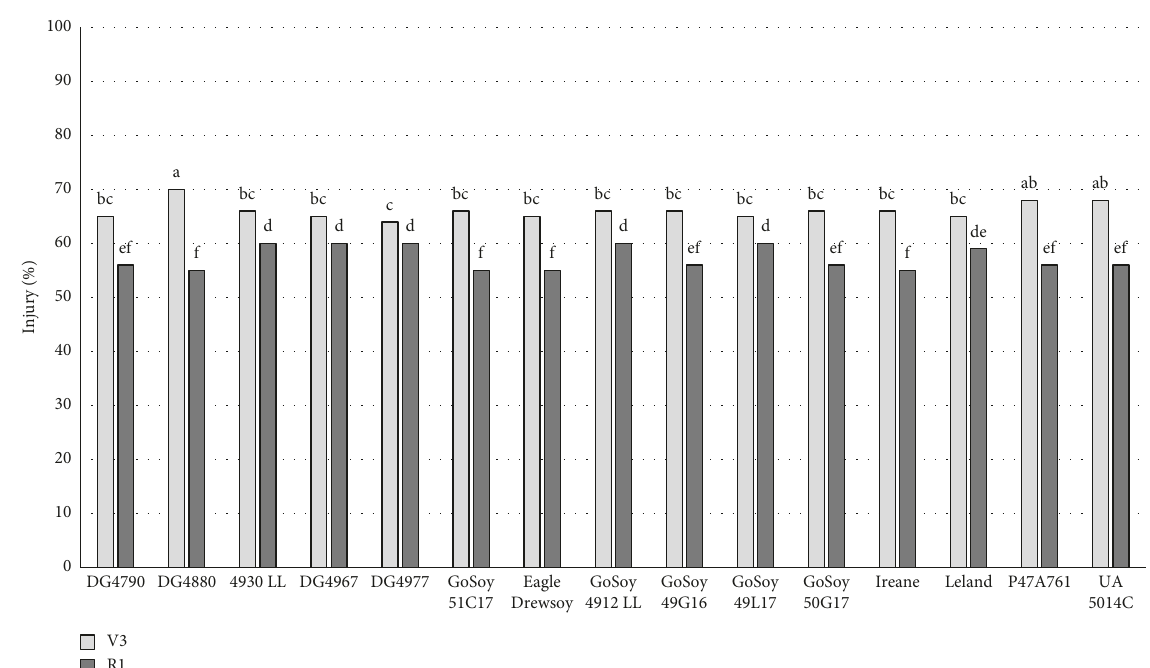
Figure 2: Visual estimates of soybean injury at 21 days after treatment according to the interaction of cultivar and application timing for the cultivar experiment conducted in Fayetteville, AR in 2019. Treatments not sharing any lowercase letter are significantly different according to multiple comparison analysis α � 0.05 [14].